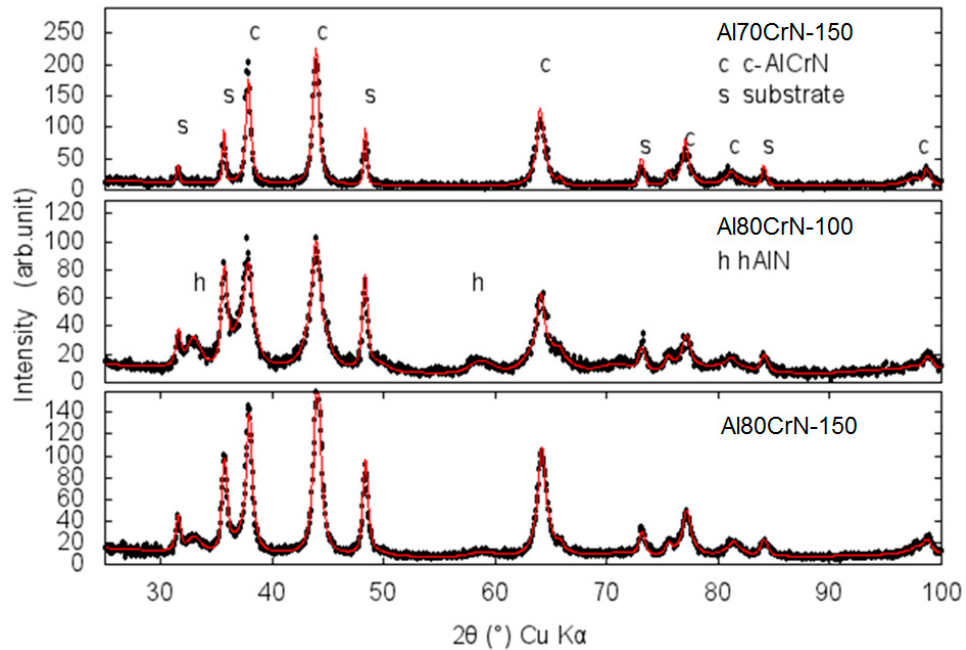
Figure 3. Original diffraction data (black dots) and wholepattern fit (red line) for selected Al 70 Cr 30 N and Al 80 Cr 20 N variants (c = cubic AlCrN, s = substrate WC, h = hexagonal AlN).